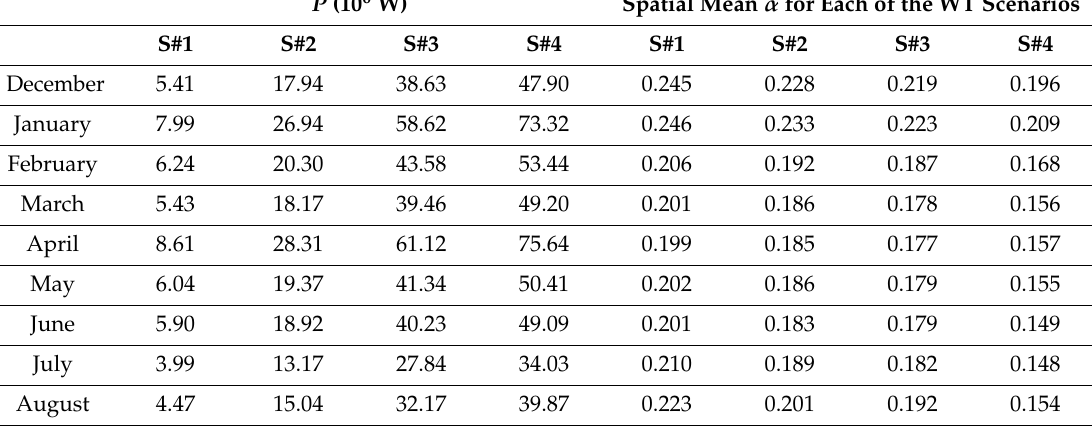
Table 3. The mean monthly power (averaged over the four transect locations) and domain-average shear exponent for the four WT scenarios computed for all WRF grid cells within the inner modeling domain. Estimates presented here have been corrected for the month-to-month variation in model layer height. P (10 6 W) Spatial Mean α for Each of the WT